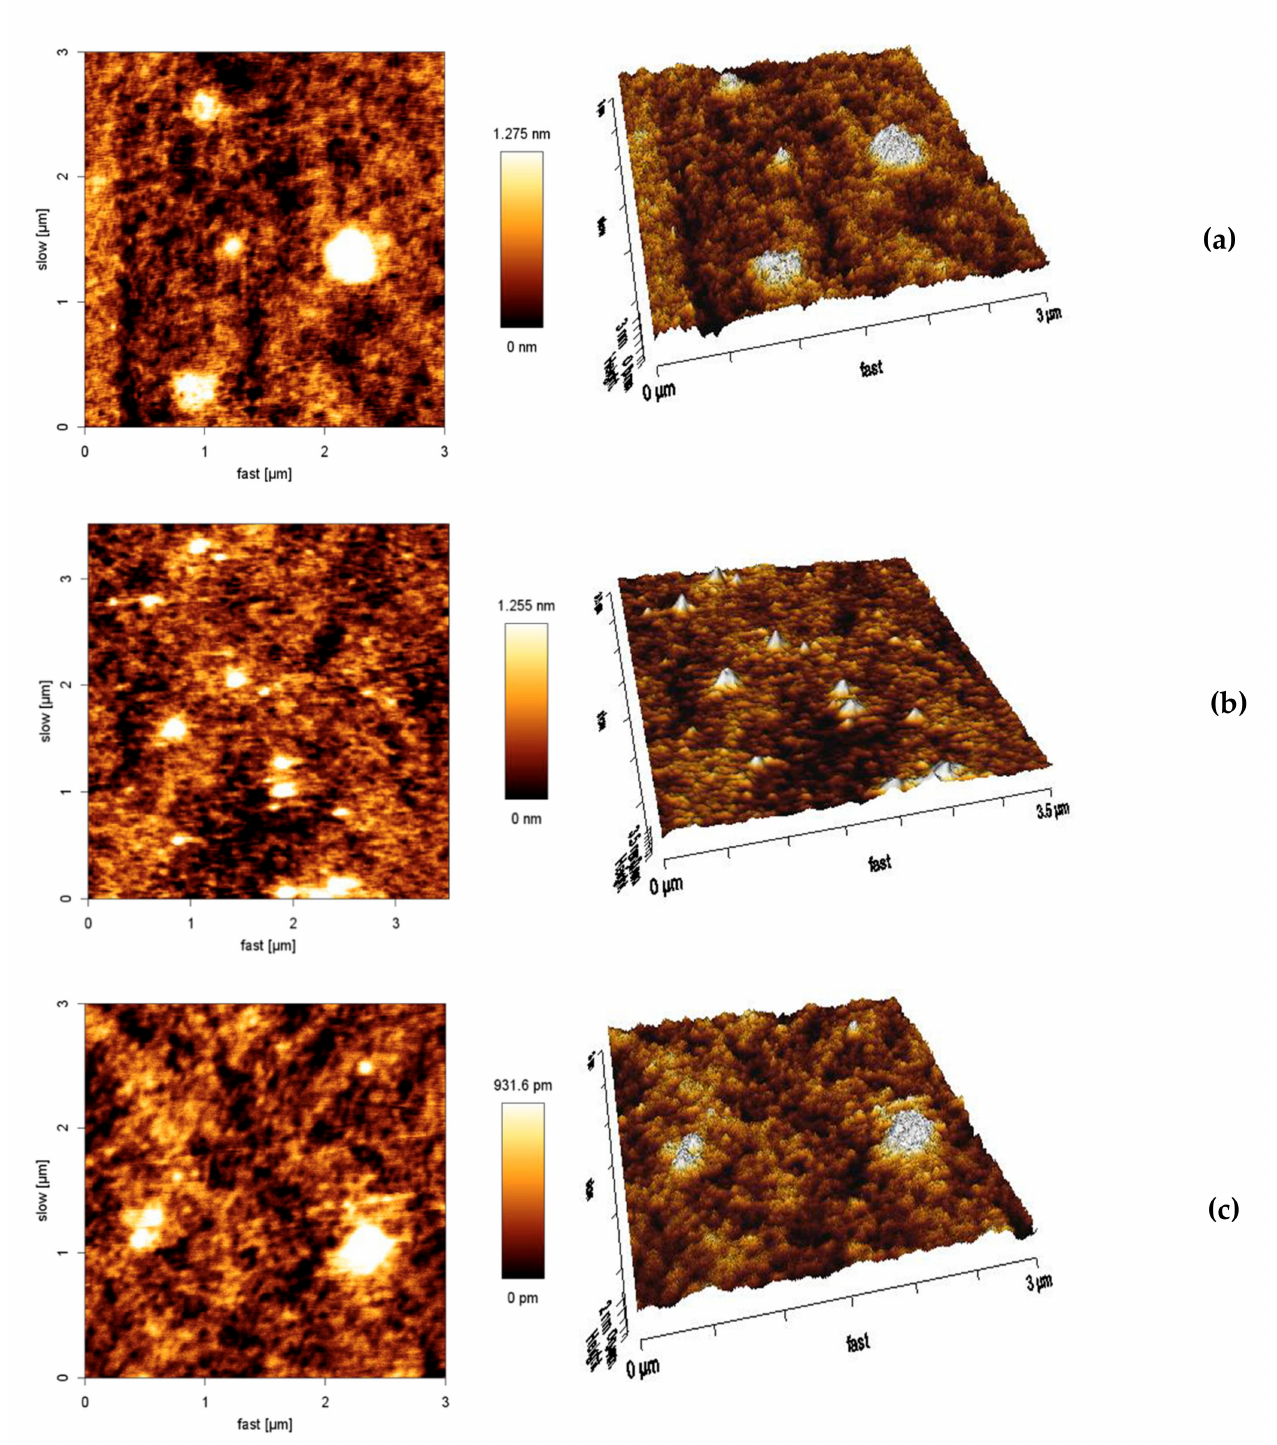
Figure 6. AFM images of empty SLNs ( a ), etofenamate-SLNs ( b ), and ibuprofen-SLNs ( c ).